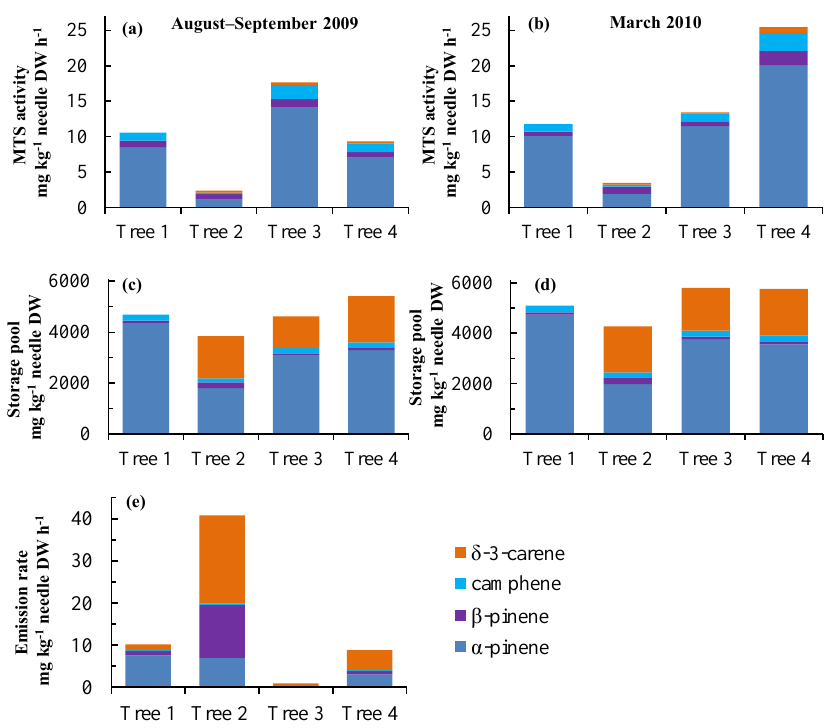
Figure 6. (a, b) Tree-to-tree variation for 2009 needles in monoterpene synthase activity and (c) and (d) monoterpene storage in late sum- mer/autumn (August–September 2009: a, c, e approx. two-month-old needles) and in early spring (March 2010: b, d approx. nine-month-old needles). (e) Monoterpene emission rates were measured from all the trees studied in August